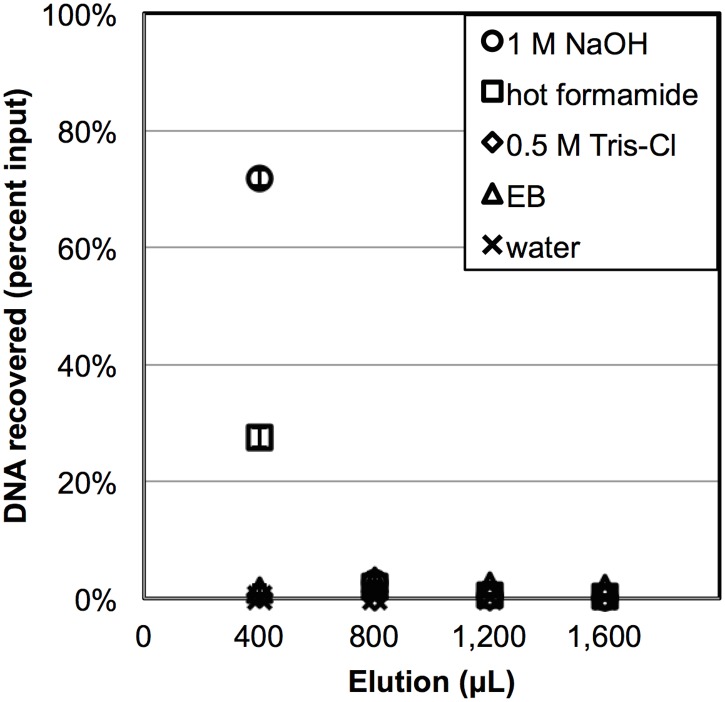
Elution of DNA from silica using varying elution buffers.Amount of recovered DNA using five different elution buffers. Samples were eluted after 1 μg DNA was incubated with silica in adsorption solution D (5 M GUSCN pH 3). (n = 3).